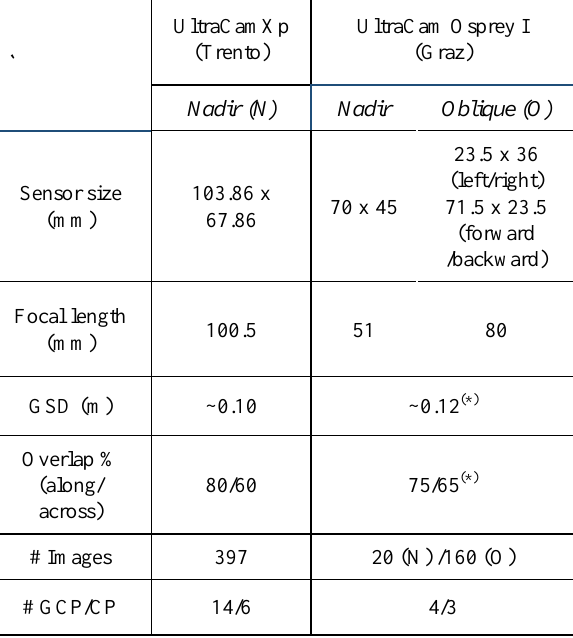
Table 1. Specifications of cameras and datasets adopted for geometry reconstruction. (*) Computed on nadir